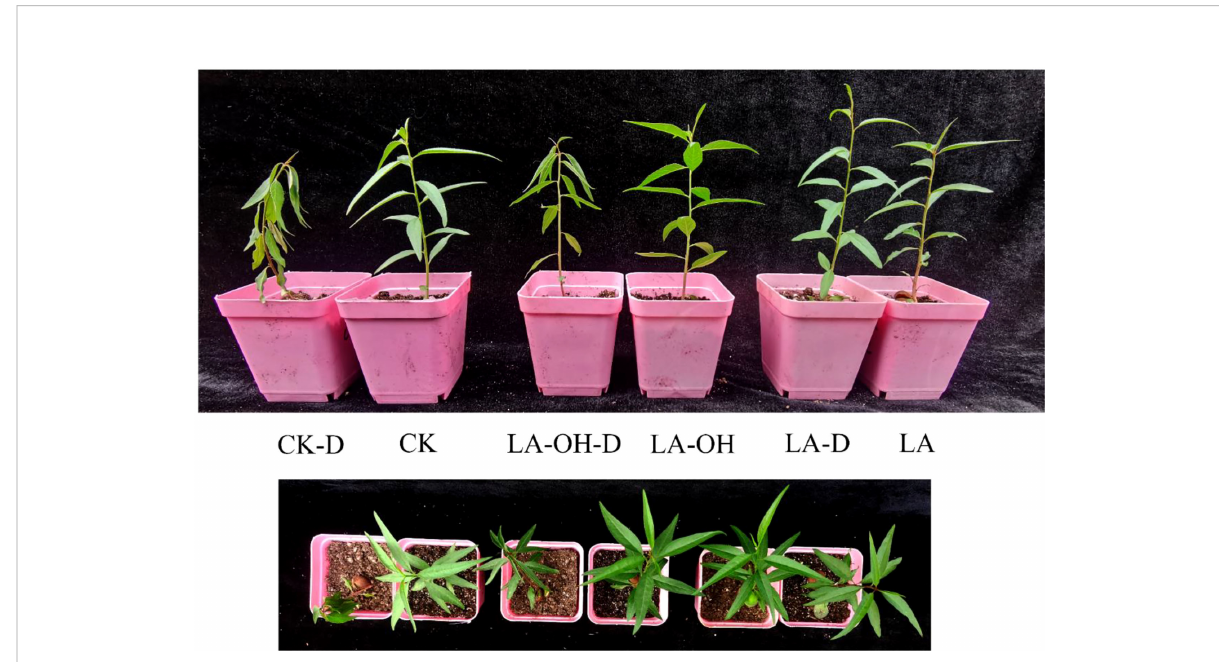
FIGURE 1 Drought tolerance of P. persica was increased by 12-Hydroxylauric acid and Lauric acid pretreatment. The detailed treatments of CK-D, CK, LA- OH-D, LA-OH, LA-D and LA are described in Materials and methods 2.2.